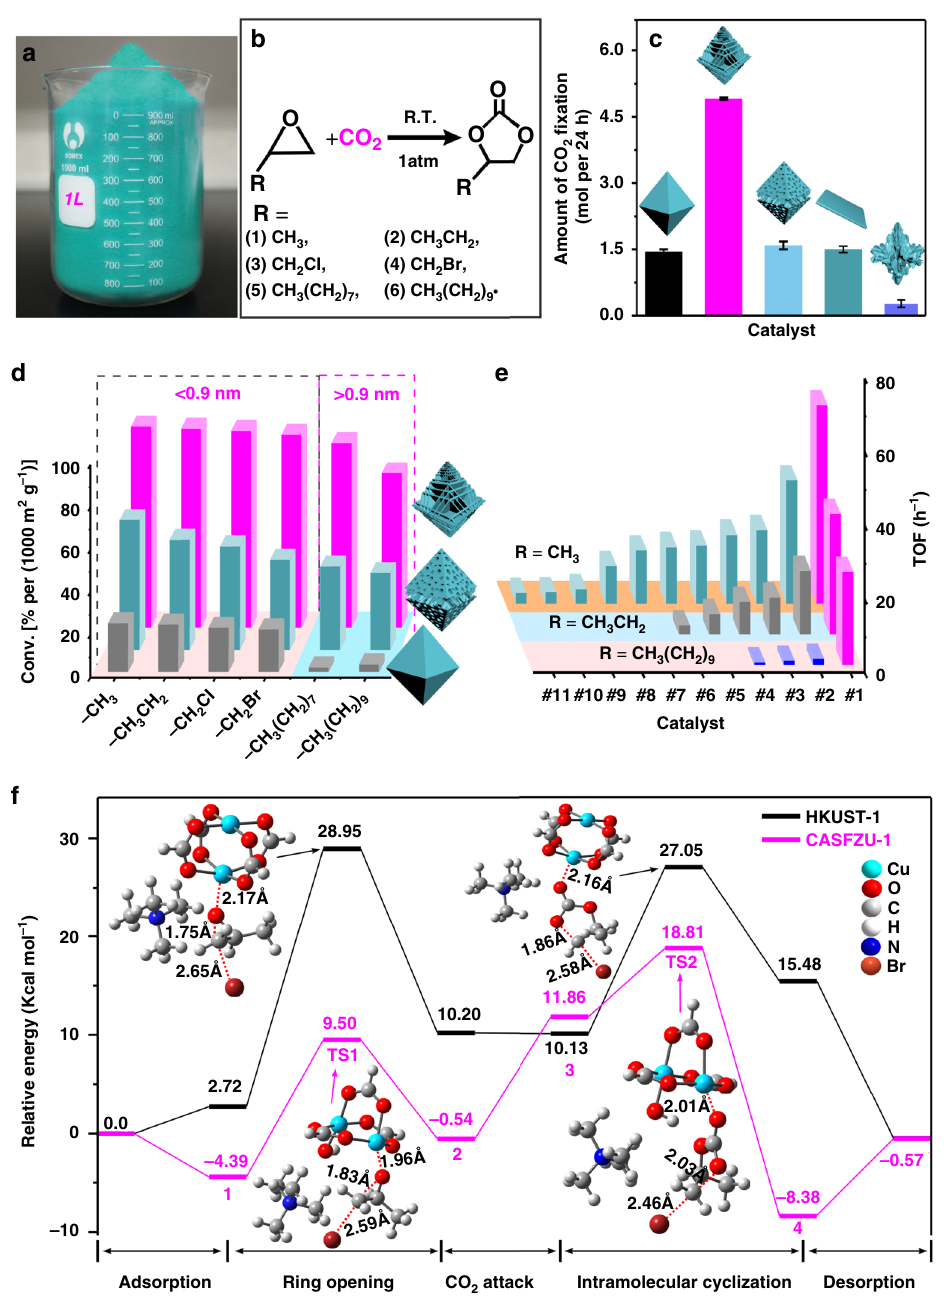
Fig. 4 Catalytic activity and density functional theory (DFT) calculations. a Photographs of the ca .1.0 kg of CASFZU-1 prepared in the laboratory. b Scheme for cycloaddition of CO 2 with epoxides to produce cyclic carbonates catalysed by CASFZU-1. c The amount of CO 2 fi xation with 2-methyloxirane by chemical conversion reactions catalysed by 1 g of different MOFs in 24 h. From left to right, the columns represent MOF crystals of pristine HKUST-1, CASFZU-1 and random-etching MOFs, HKUST-1 nanosheet and collapsed MOF forms. Error bars represent the standard deviation of three replicate samples. d Conversion for cycloaddition of CO 2 with the six epoxides catalysed by HKUST-1 (grey), random-etching MOFs (light blue) and CASFZU-1 (red) after normalising BET. Columns from left to right represent 2-methyloxirane; 2-ethyloxirane; 2-(chloromethyl)oxirane; 2-(bromomethyl)oxirane; 2- octyloxirane; and 1, 2-epoxydodecane. e Turnover frequency (TOF) comparison of CASFZU-1 with the other catalysts in representative publications on catalysis of the cycloaddition reaction of CO 2 with 2-methyloxirane, 2-ethyloxirane and 1,2-epoxydodecane (see Supplementary Tables 7 – 9 for details). The rightmost red columns represent CASFZU-1. f The computed reaction energy pro fi les of the CO 2 fi xation reaction on HKUST-1 and CASFZU-1. TS, transition state. The pathways are divided into fi ve steps: (i) adsorption of epoxy; (ii) epoxy ring opening step; (iii) CO 2 electrophilic attack step; (iv) intramolecular cyclisation step; (v) product desorption (see Supplementary Figures 49, 51 and 52 for more details and references). Colour scheme for chemical representation: cyan, Cu; red, O; grey, C; tangerine, Br; blue, N; white,